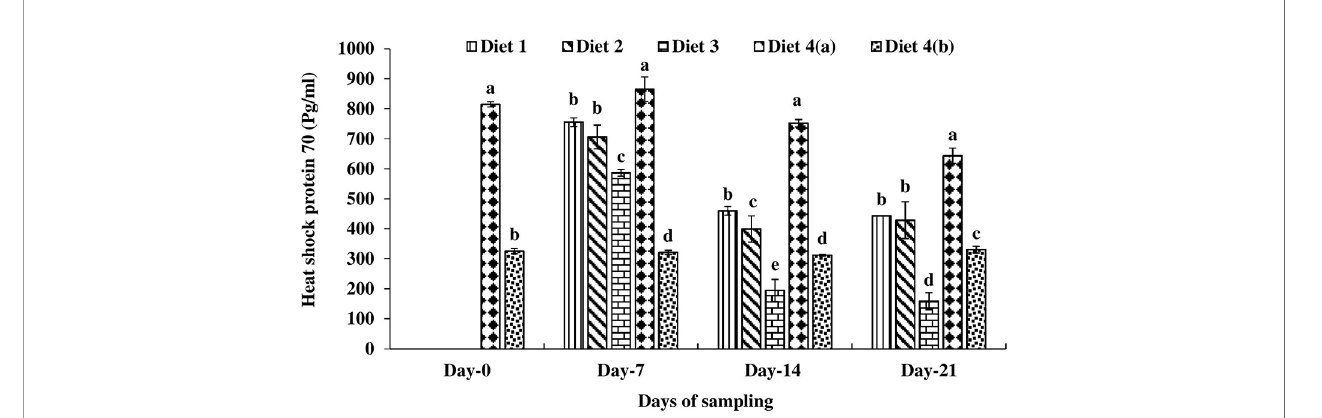
FIGURE 7 | Heat shock protein (Hsp) 70 level found in four different diets fed UV-B exposed and unexposed Catla catla . Bars with different superscripts (a-e) are signi fi cantly different (n = 3).